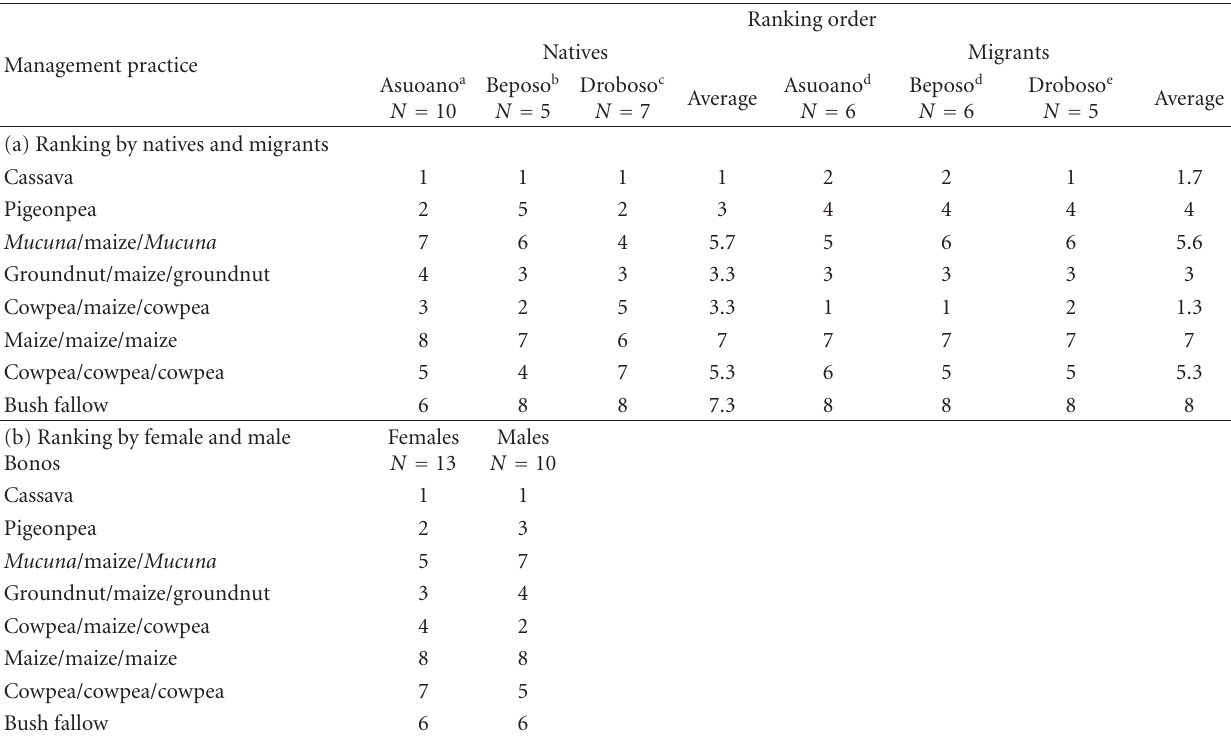
Table 5: Preferential ranking of di ff erent soil fertility management practices by native and migrant farmers in Wenchi.